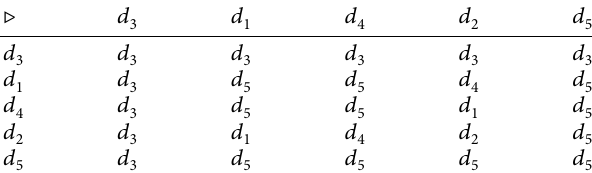
Table 7: Rankings of bridge designs under ( C , ⊖ ) .